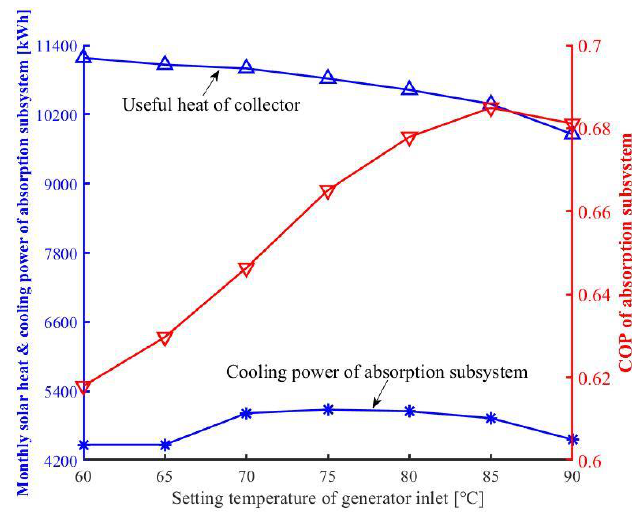
Figure 12. Impact of set point temperature of generator inlet.